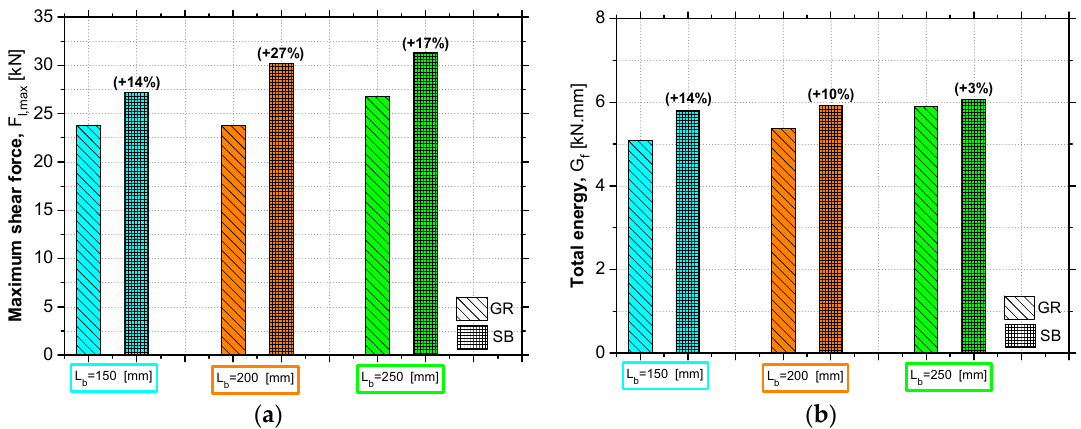
Figure 9. Influence of study parameters on the: ( a ) maximum pull shear force; ( b ) total energy. Note: the values in parentheses represents the percentage increase when SB was applied instead of GR.